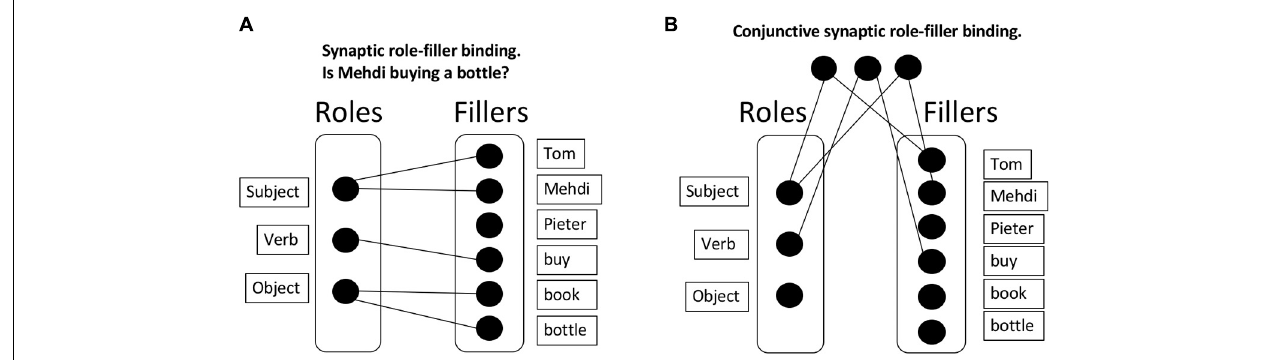
FIGURE 1 | Synaptic binding. (A) Synaptic role-filler binding. This approach allows to bind roles and fillers but has an important downside: After the presentation of multiple sentences, the roles and fillers are soon saturated, connecting all roles with all fillers. If synapses are not immediately removed, this approach will lead to interference; which we refer to as the unbinding problem. (B) Conjunctive synaptic role-filler binding. An alternative solution is to implement a set of “gates” that would, for instance, activate specific roles and fillers. Once activated, a gate would activate the corresponding (role or filler) elements. This approach has the same unbinding problem, and additionally presents a combinatorial problem: 3N 2 gates must be created to store all possible